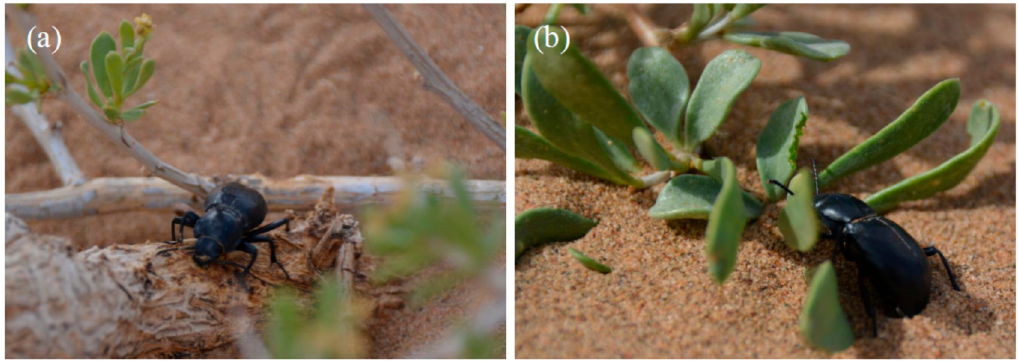
Figure 10. Anatolica potanini feeding on Nitraria tangutorum . ( a ) Feeding on damaged tissues; ( b ) feeding on leaves. feeding on